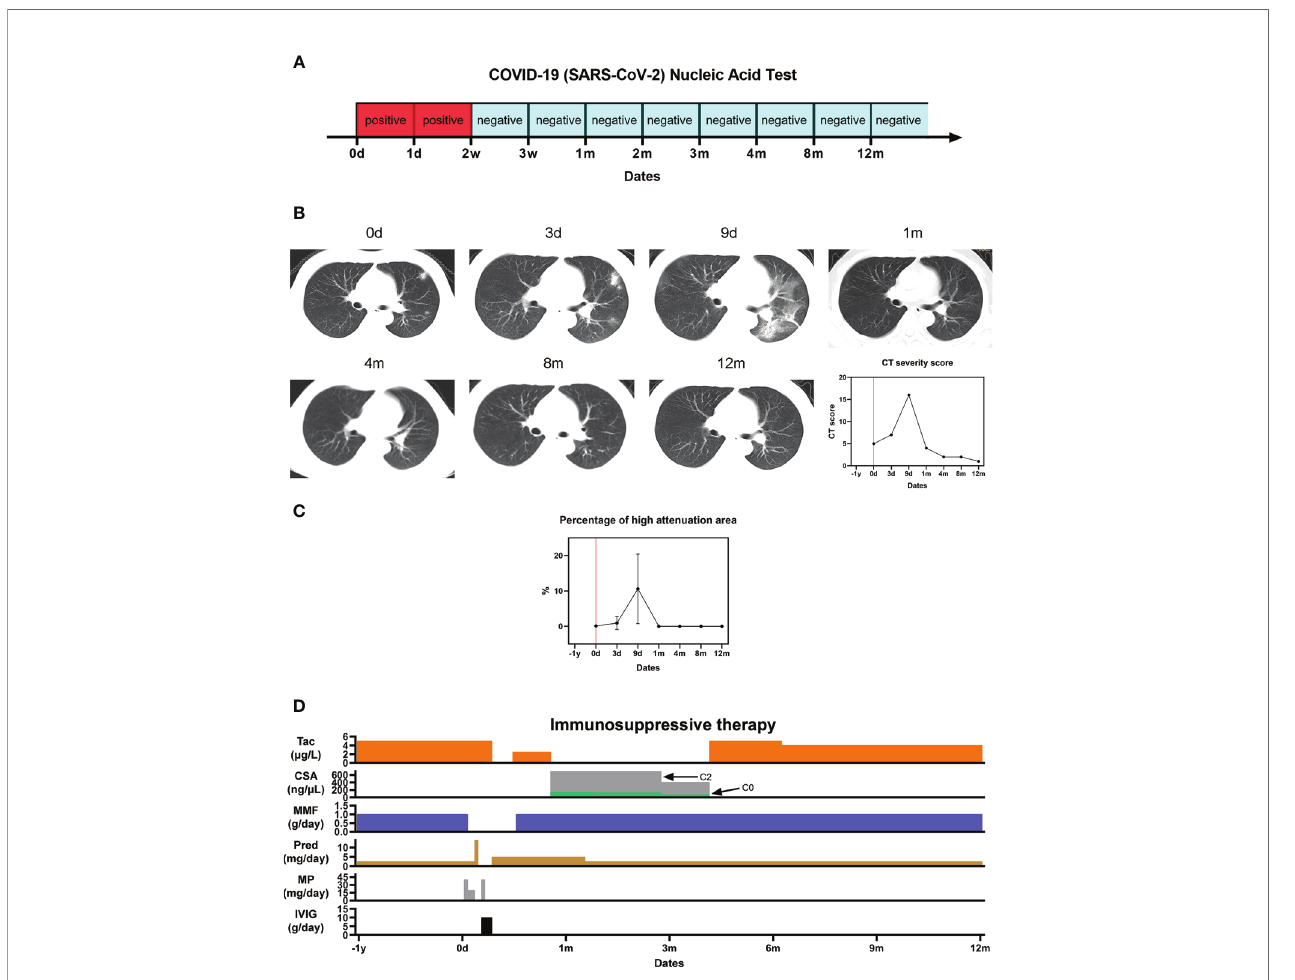
FIGURE 1 | Pulmonary sequelae of COVID-19. (A) SARS-Cov-2 nucleic acid test results; (B) Serial CT thorax images at different timepoints from initial presentation of symptoms, and the corresponding COVID-19 CT severity score; (C) Percentage of high attenuation area (HAA%) on CT imaging indicating pulmonary fi brosis; (D) Immunosuppressive therapy regime before, during and after the patient ’ s hospitalization for severe